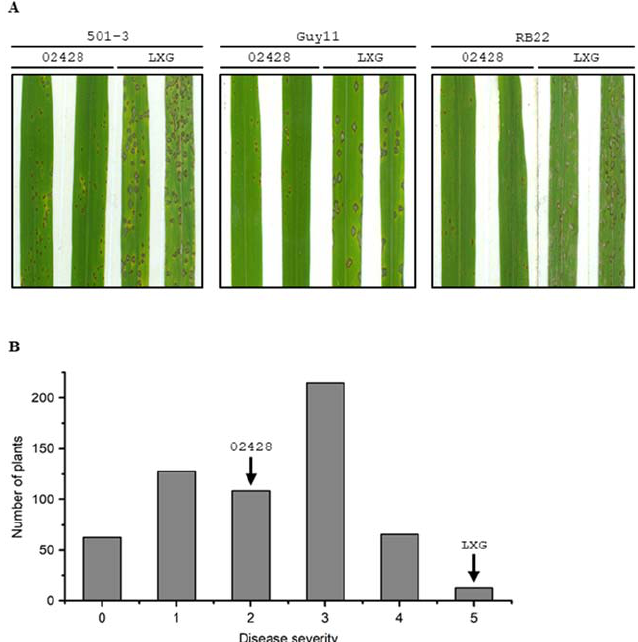
Figure 1. Resistance reaction of rice varieties 02428, LiXinGeng (LXG) and their F 2 population to rice blast disease. ( A ) Phenotypes of 02428 and LXG inoculated with M. oryzae isolates 501-3, Guy11, and RB22. ( B ) The frequency distribution of disease severity in the F 2 population of 02428 × LXG inoculated with M. oryzae isolate RB22. Disease severity was assessed following a 0–5 scale (0–1: resistant, 2: moderately resistant, 3: moderately susceptible, 4–5: severely susceptible).